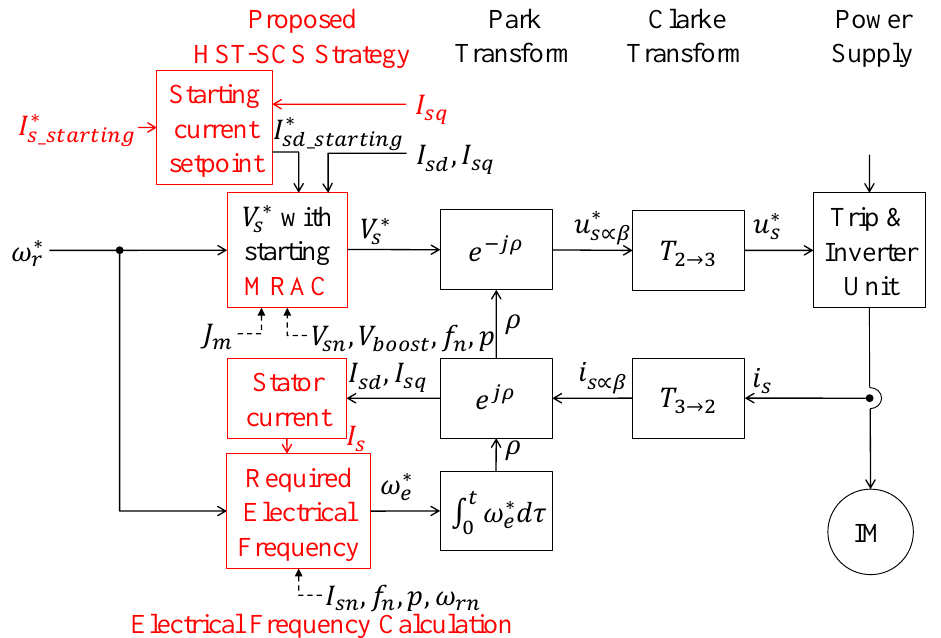
Figure 2. General block diagram of the propose HST-SCS for IMs, remarking the differences in